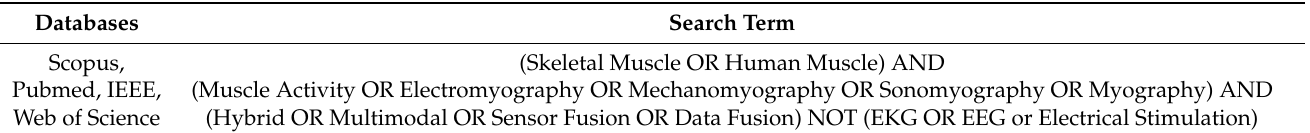
Table 1. Databases used for the literature survey and the search terms employed. Databases Search Term Scopus, (Skeletal Muscle OR Human Muscle) AND Pubmed, IEEE, (Muscle Activity OR Electromyography OR Mechanomyography OR Sonomyography OR Myography) AND Web of Science (Hybrid OR Multimodal OR Sensor Fusion OR Data Fusion) NOT (EKG OR EEG or Electrical